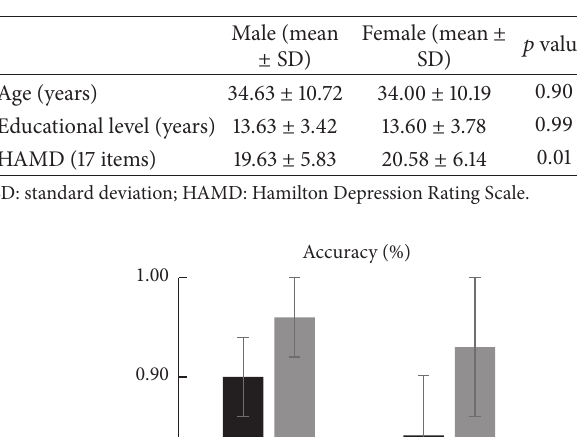
Table 1: Demographic data analysis.